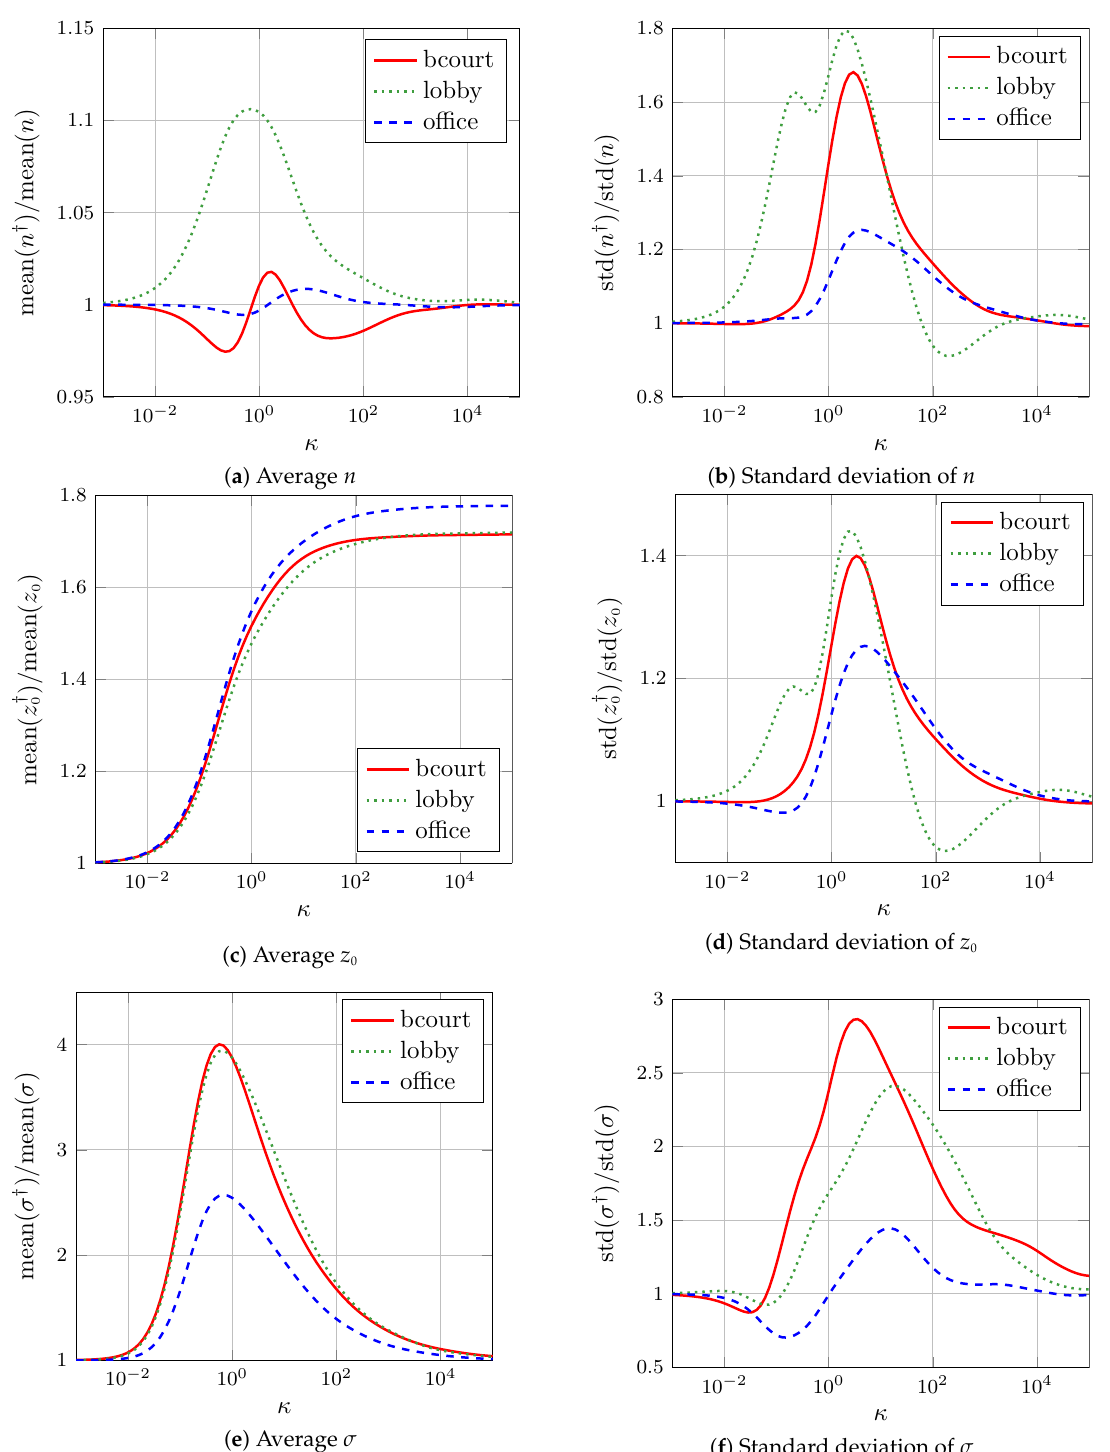
Figure 7. Relative increments of the mean and standard deviation of the model parameters’ empirical distributions as a function of antenna directivity. Parameters with † refer to models with the addition of a virtual antenna, and those without it to the original